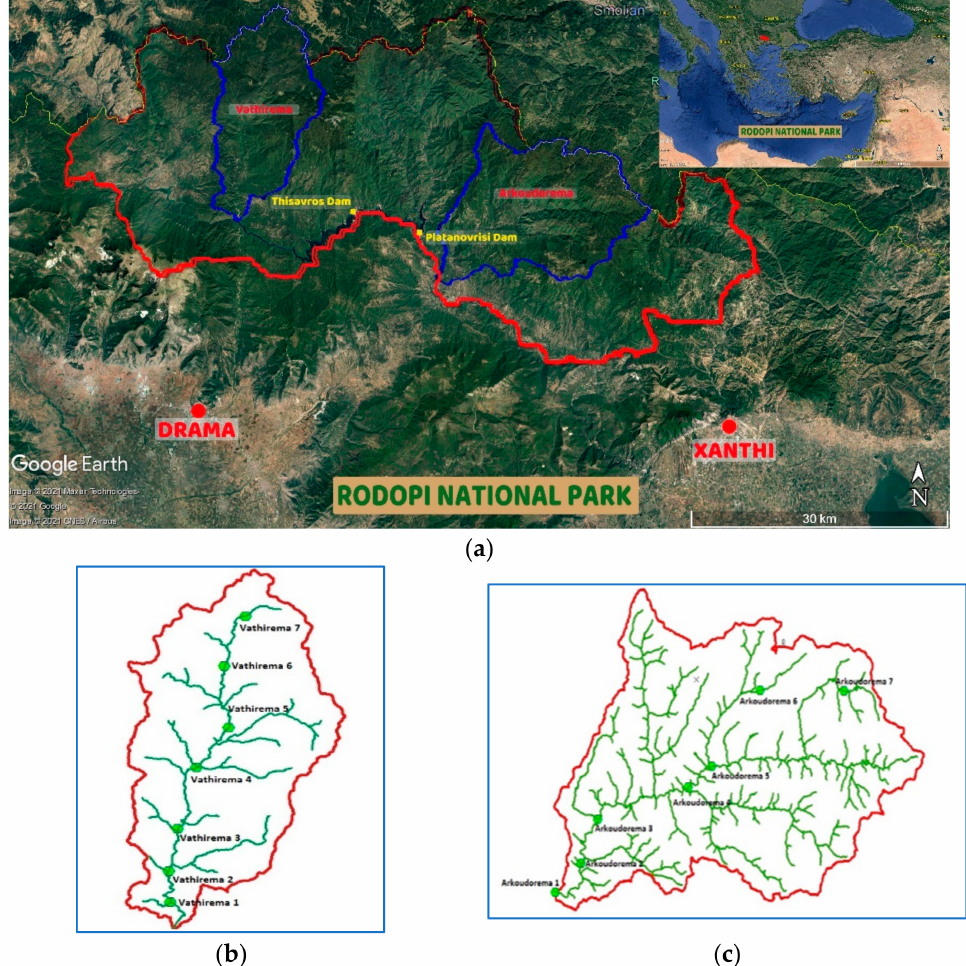
Figure 1. The Rhodopi Mountain Range National Park (red line), the studied sub-watersheds (blue line) and two major dams (yellow dots) along Nestos River in Northern Greece (source: google earth) ( a ). The two studied watersheds (red line) of Vathirema (VTR) ( b ) and Arkoudorema (ADR) ( c ) with their stream network (green lines) and sampling stations (green